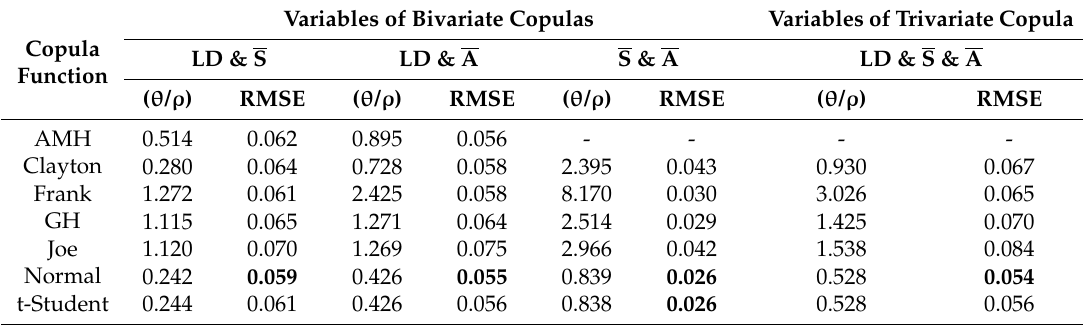
Table 5. Parameters ( θ or ρ ) and RMSE values of bivariate and trivariate copula fitting simulations, where the three smallest RMSE values are written in bold for each